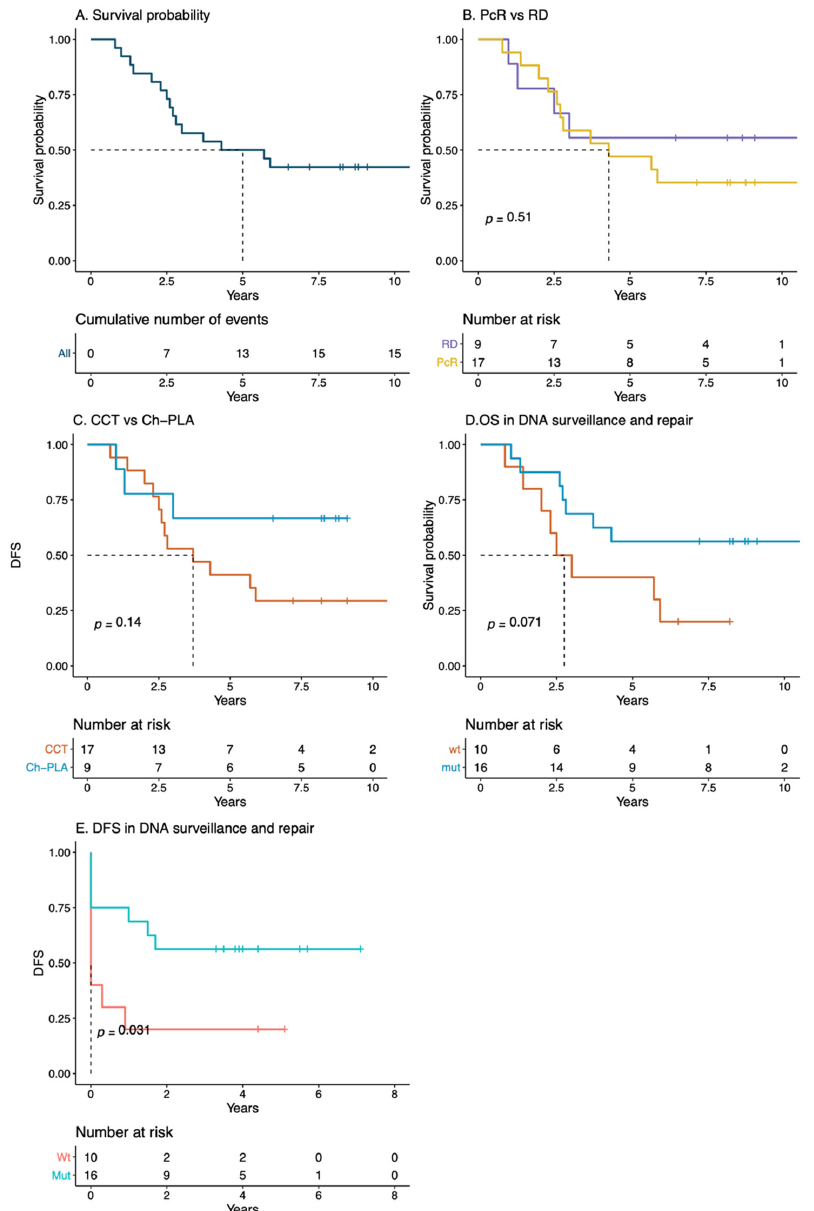
Figure 1. Overall survival (OS) probability ( A ) was assessed according to pathologic complete response ( B ) and therapeutic regime ( C ). The effect of deficiency in DNA repair and surveillance genes was evaluated for overall survival ( D ) and disease-free survival ( E ). PCR: Pathologic complete response; CCT: Conventional chemotherapy; Ch-PLA: Chemotherapy plus platinum salts.